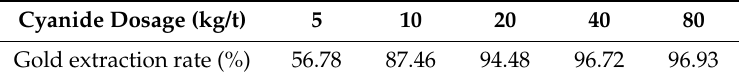
Table 3. The gold extraction rate of acid-leaching